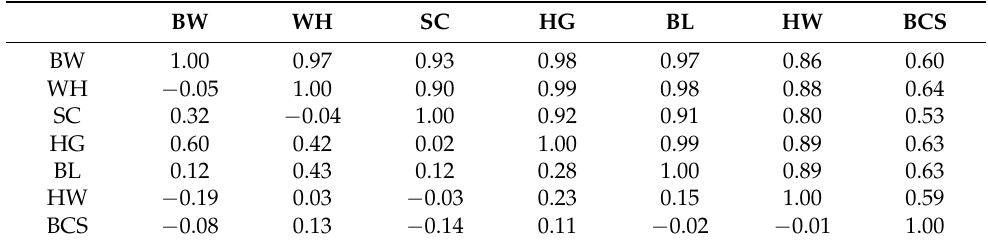
Table 4. Values concerning the coefficient of correlation between different measures used for BW estimation in 25 rearing Holstein